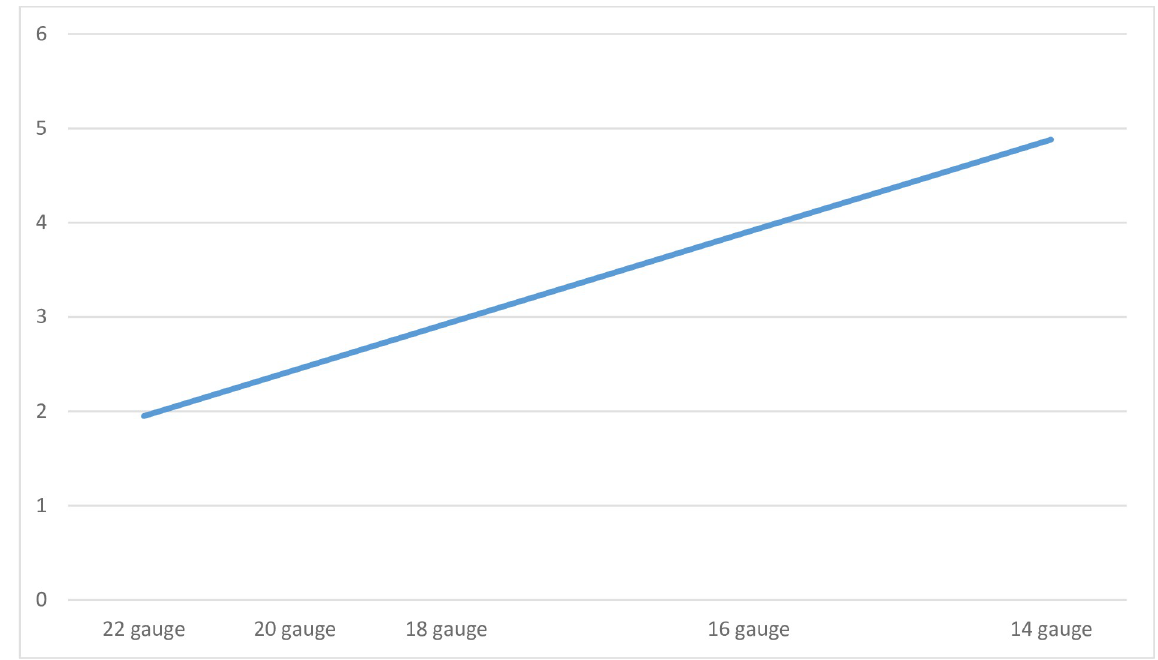
Fig 2. The relation between venous diameter and the size of the inserted catheter to guarantee a CVR < 41%. Venous diameter in millimeters (vertical axes) and the size of the inserted catheter (horizontal axes).